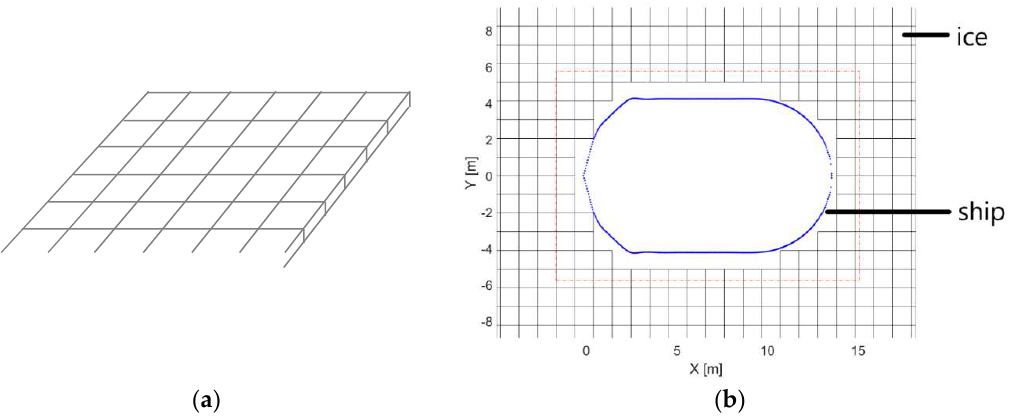
Figure 6. Sketch of the ice and the ship. ( a ) Ice field discretion; ( b ) Initial location of ship in ice.